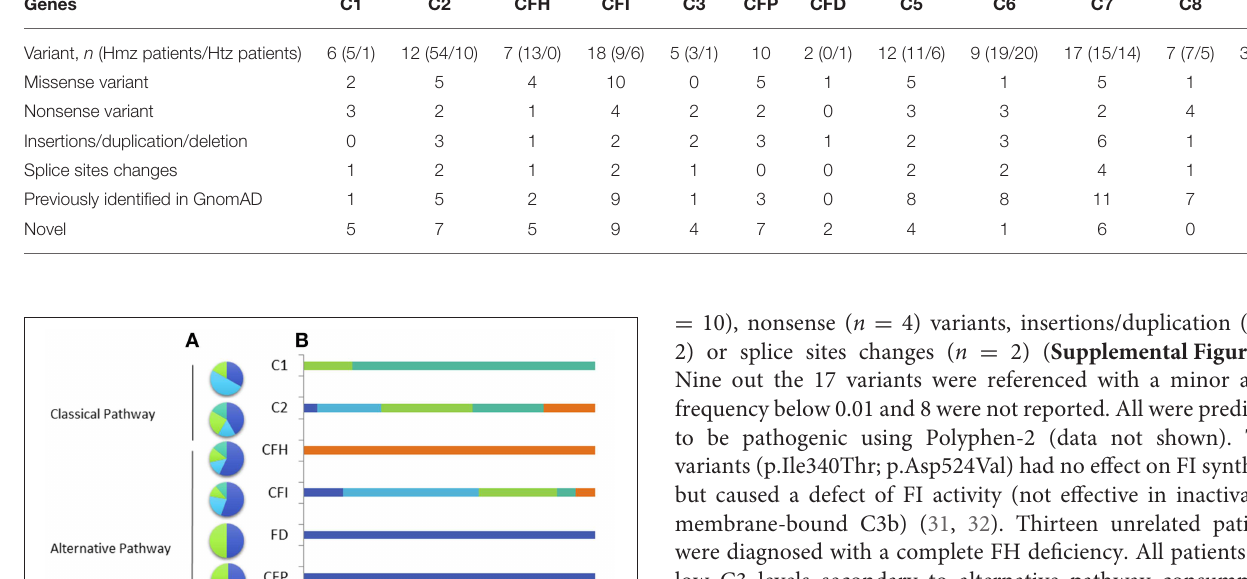
TABLE 2 | Variants spectrum associated with quantitative and functional deficiency. Genes Variant, n (Hmz patients/Htz